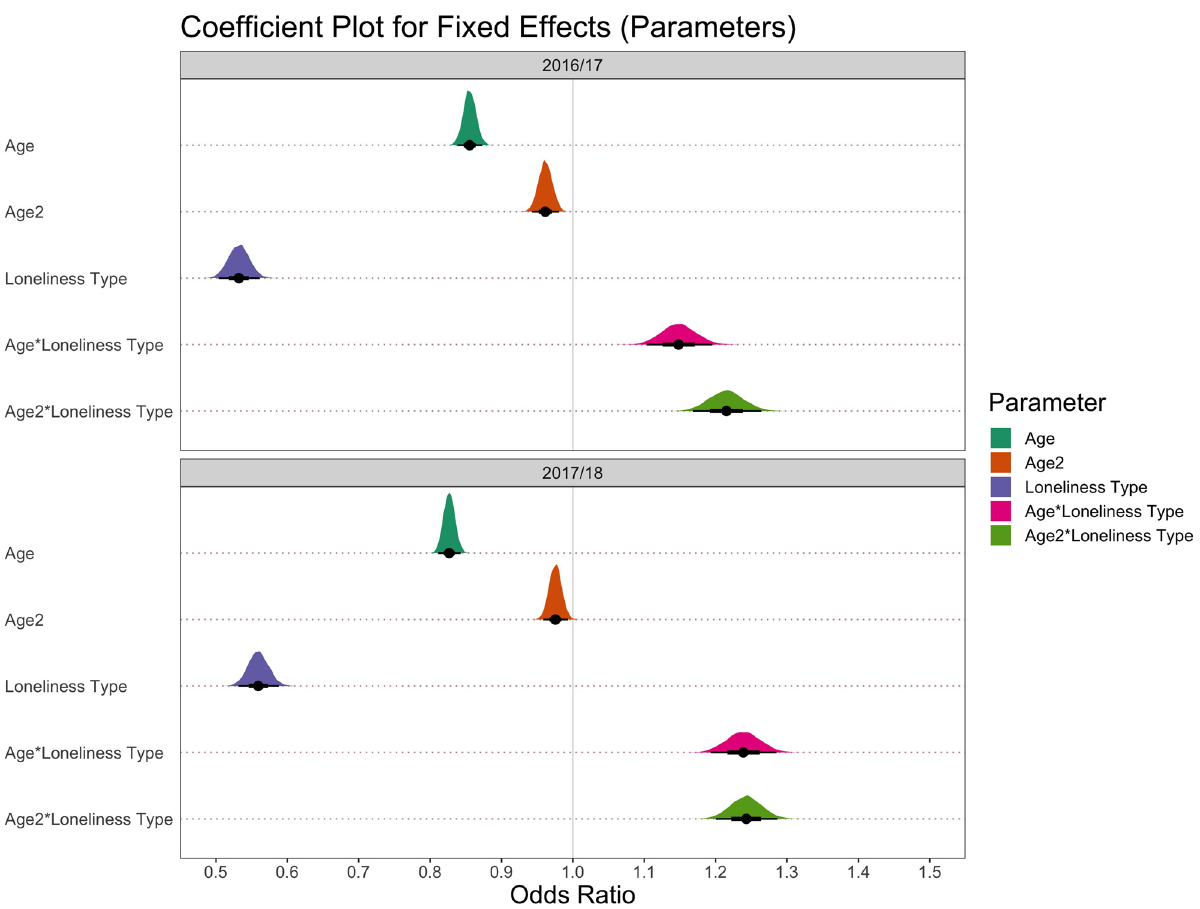
Figure 3. Odds ratios (fixed effects) of parameters for the most complex models (m3b) in each NSW dataset (2016/17, 2017/18).